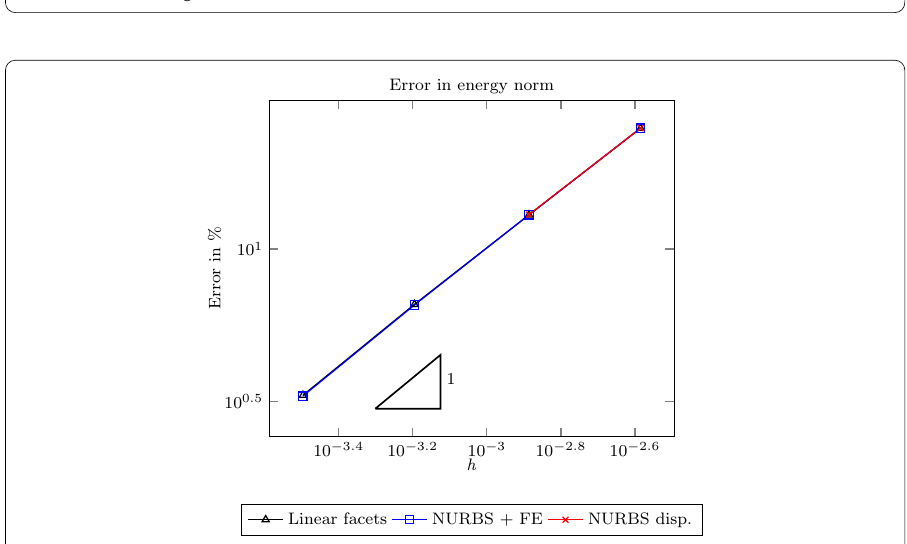
Fig. 9 Example 1: Evolution of the error in energy norm with the element size of the lower body. Convergence of the FE